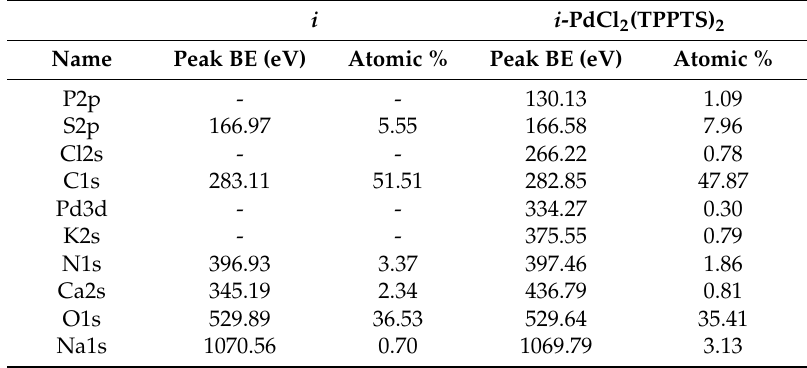
Table 5. Elemental identification and quantification of i and i -PdCl 2 (TPPTS) 2 determined by